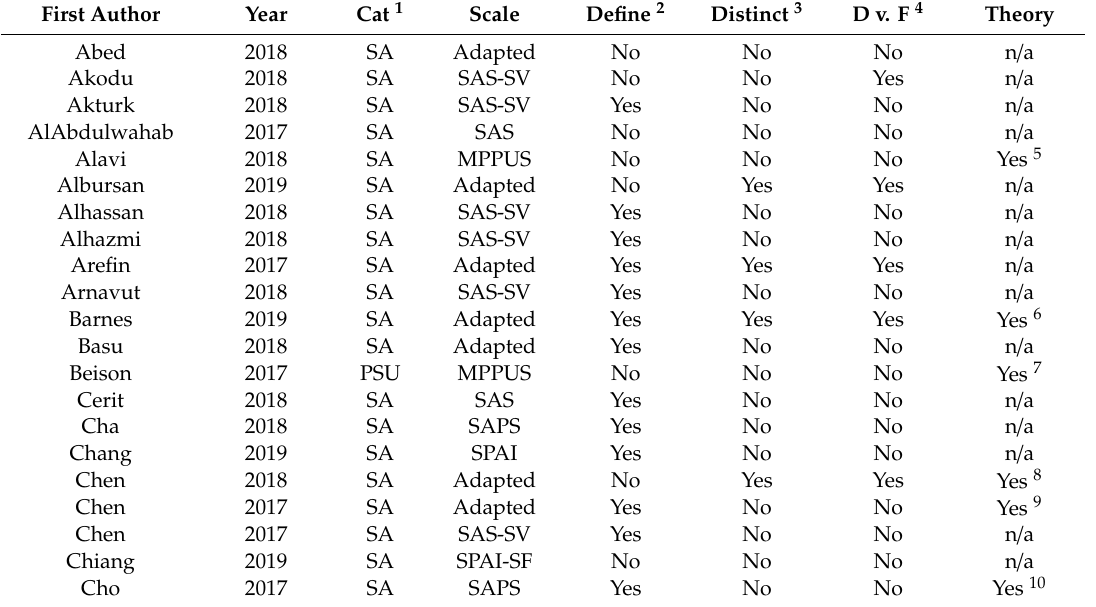
Table 3. Characteristics of relevant smartphone studies,